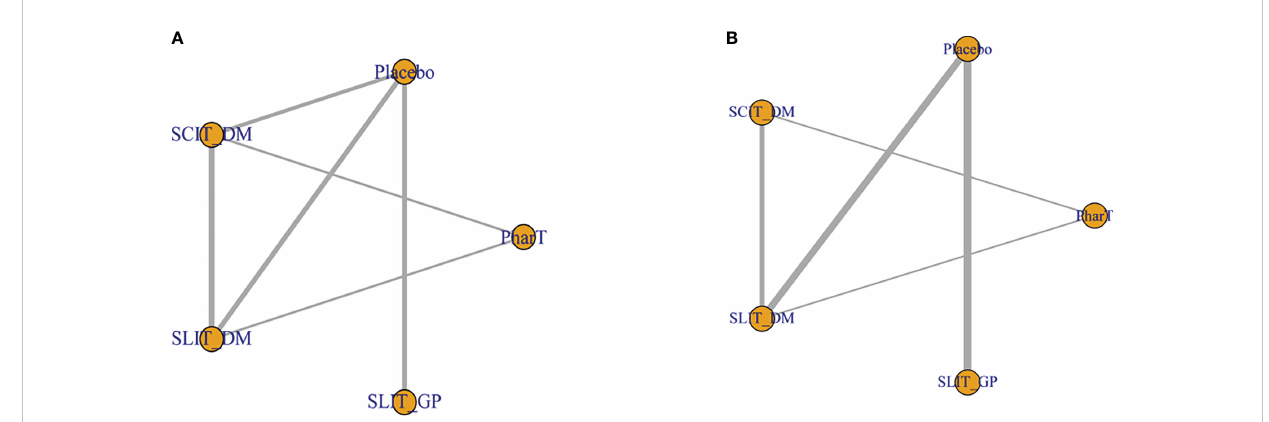
FIGURE 2 (A) Network relationship diagram for symptom score. (B) Network relationship diagram for adverse reactions.